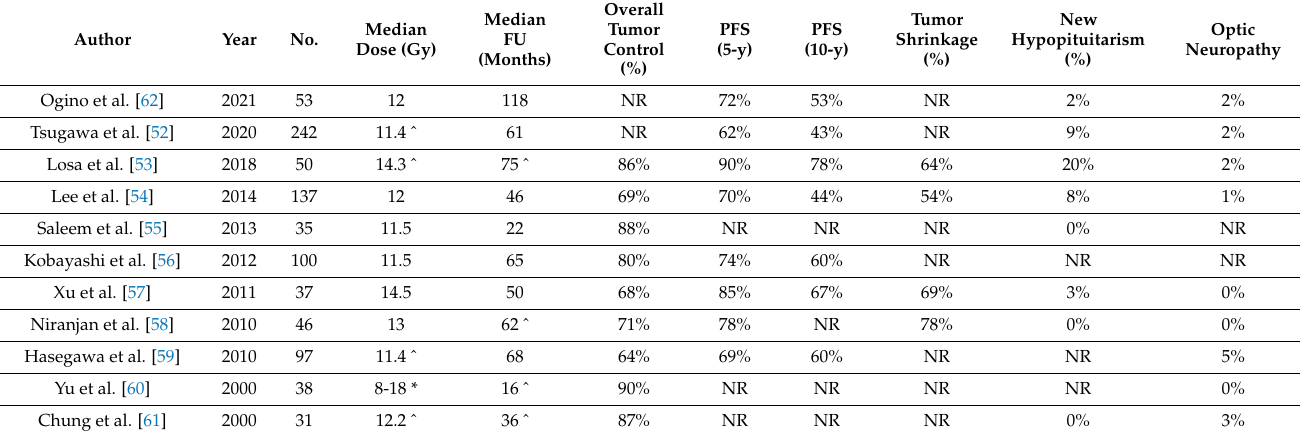
Table 5. Craniopharyngioma Gamma Knife treatment outcomes and toxicities.